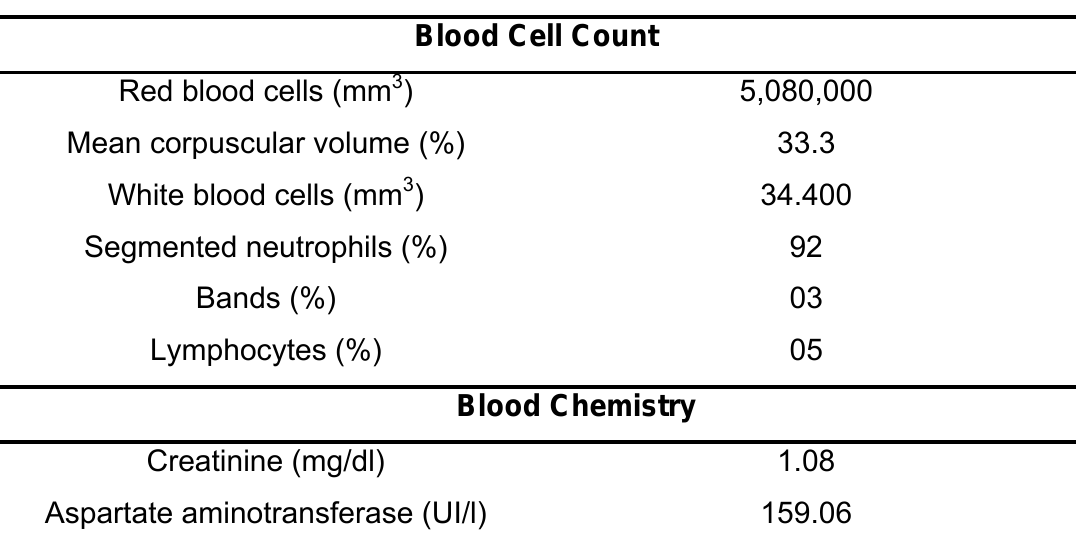
Table 2. Abnormalities in blood cell count and blood chemistry after anti- Crotalus